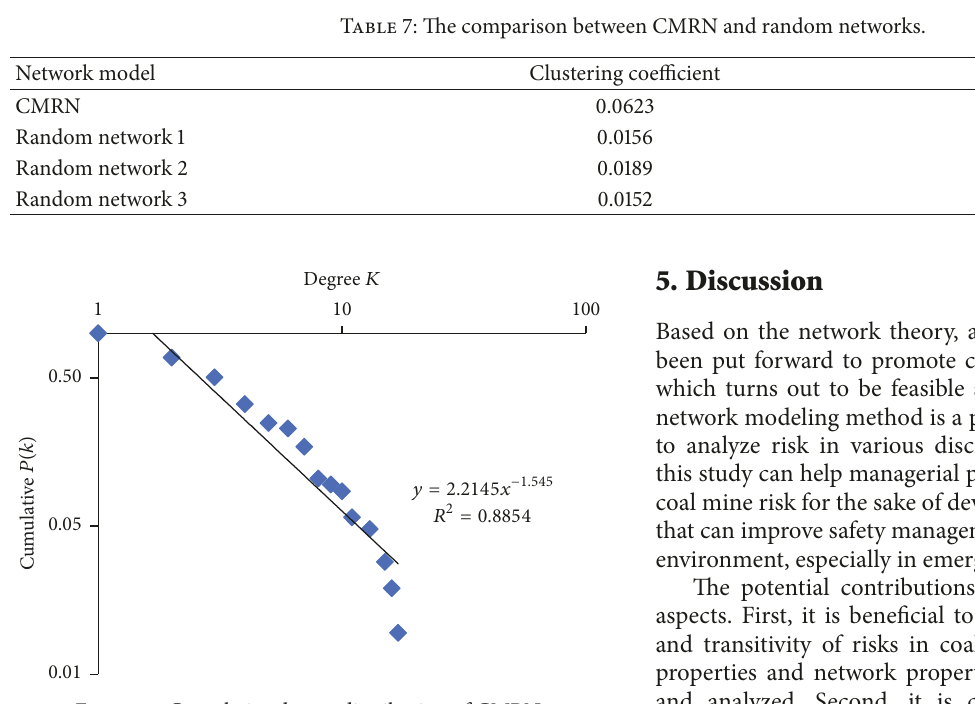
Figure 7: Cumulative degree distribution of